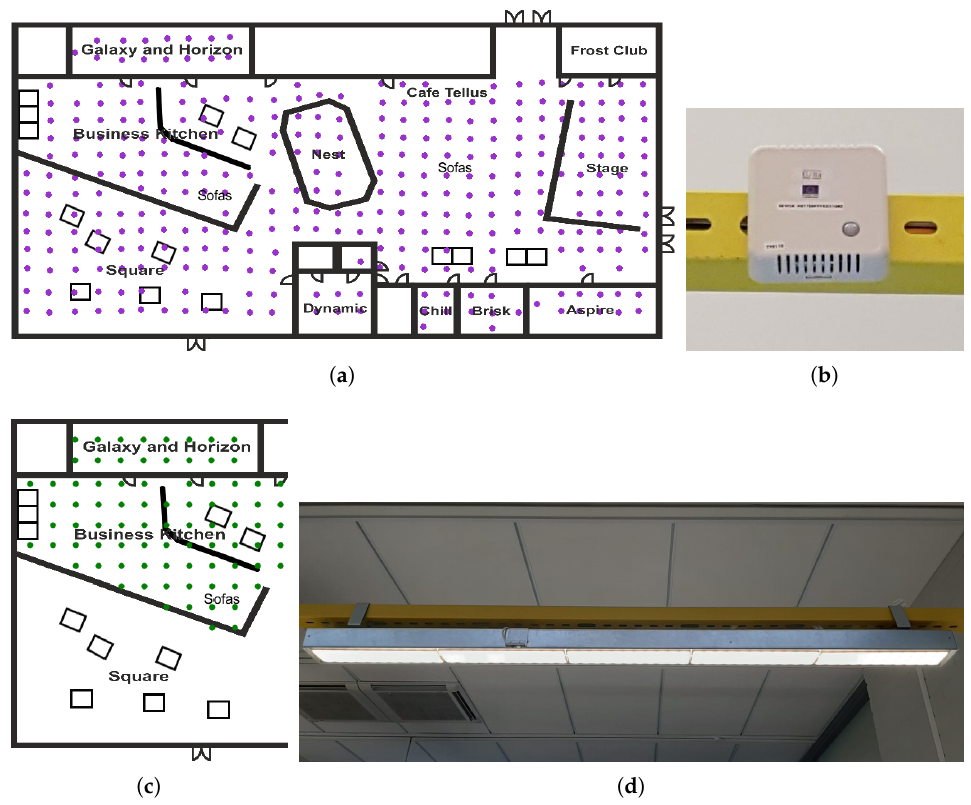
Figure 2. Sensor nodes and luminaires deployed in Tellus Innovation Arena. ( a ) The location information of deployed sensor nodes; ( b ) The sensor node; ( c ) The location information of the luminaires; ( d ) The